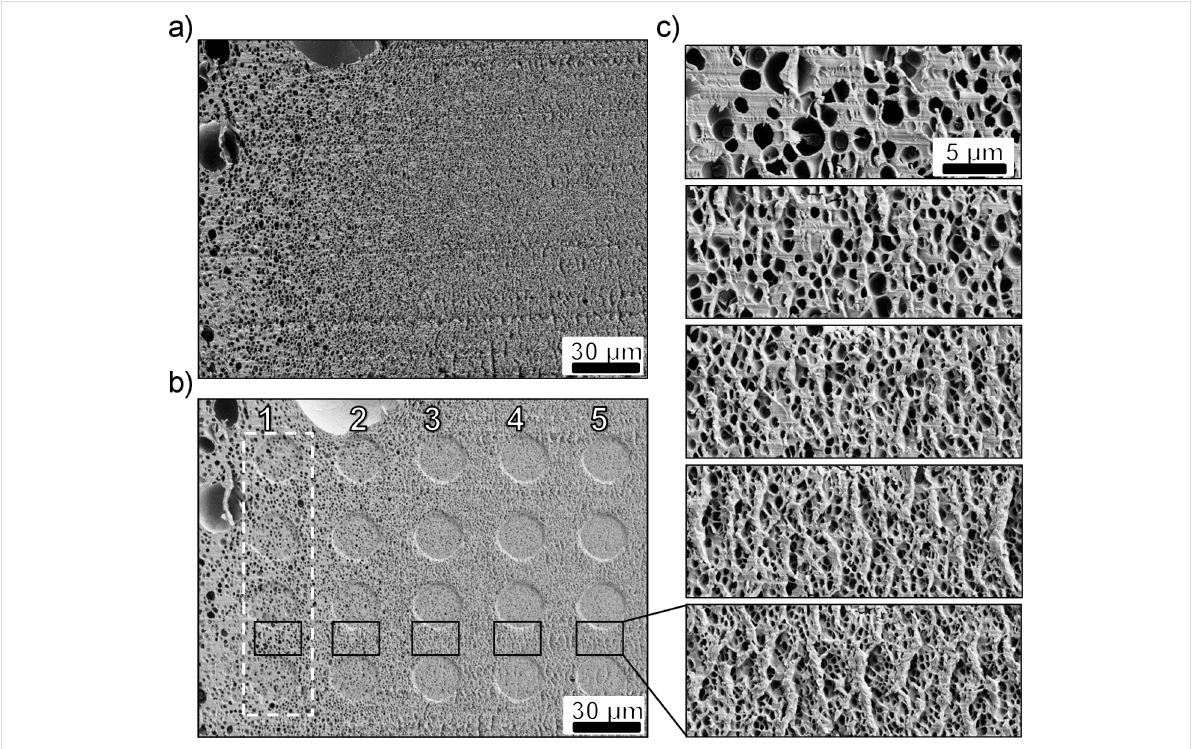
Figure 2: SEM images of the cross section with a gradient of pores before and after indentation. (a) The original surface before indentation. (b) The same sample position after indentation. The complex modulus was measured at 20 locations organised in a 5 × 4 array. The residual imprints of the flat punch are clearly visible. We numbered the columns from 1 (larger pore size and wall thickness) to 5 (smaller pores and thinner walls). (c) SEM images of the areas taken for the morphological analysis. Their positions are marked as black frames in panel